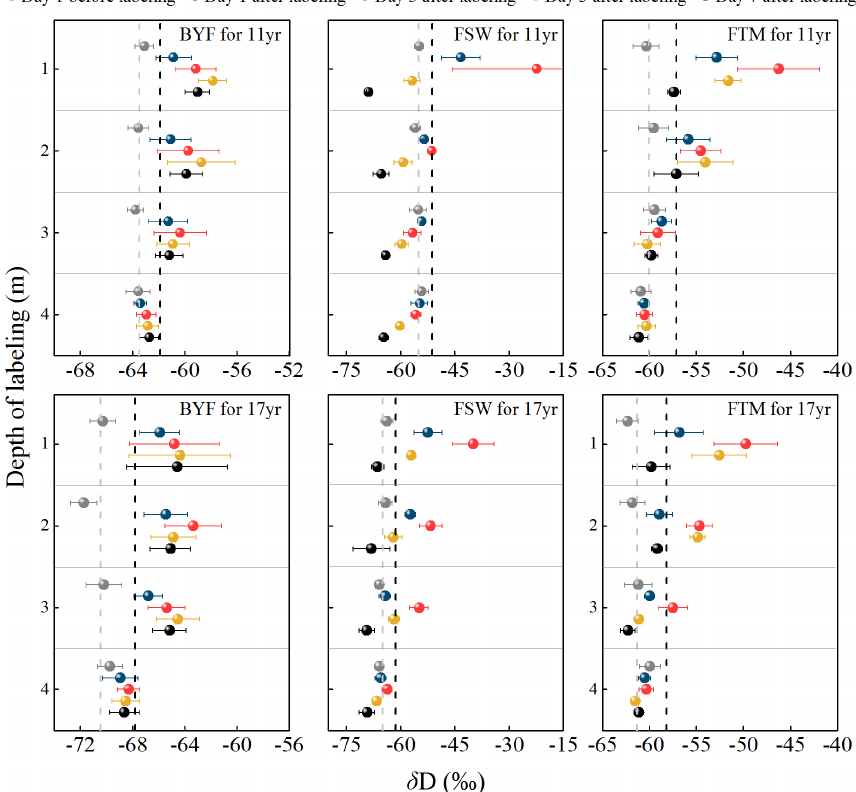
Figure 5. Temporal dynamics of δ D values in xylem water for 11- and 17-year-old apple trees. Sample collection started on day 1 before D 2 O tracer solution ( δ D = 714000‰) injection and commenced until day 7 ( N = 6). Dashed gray lines represent the background value (mean δ D values in xylem water on day 1 before labeling) and dashed black lines represent 2SD above the background